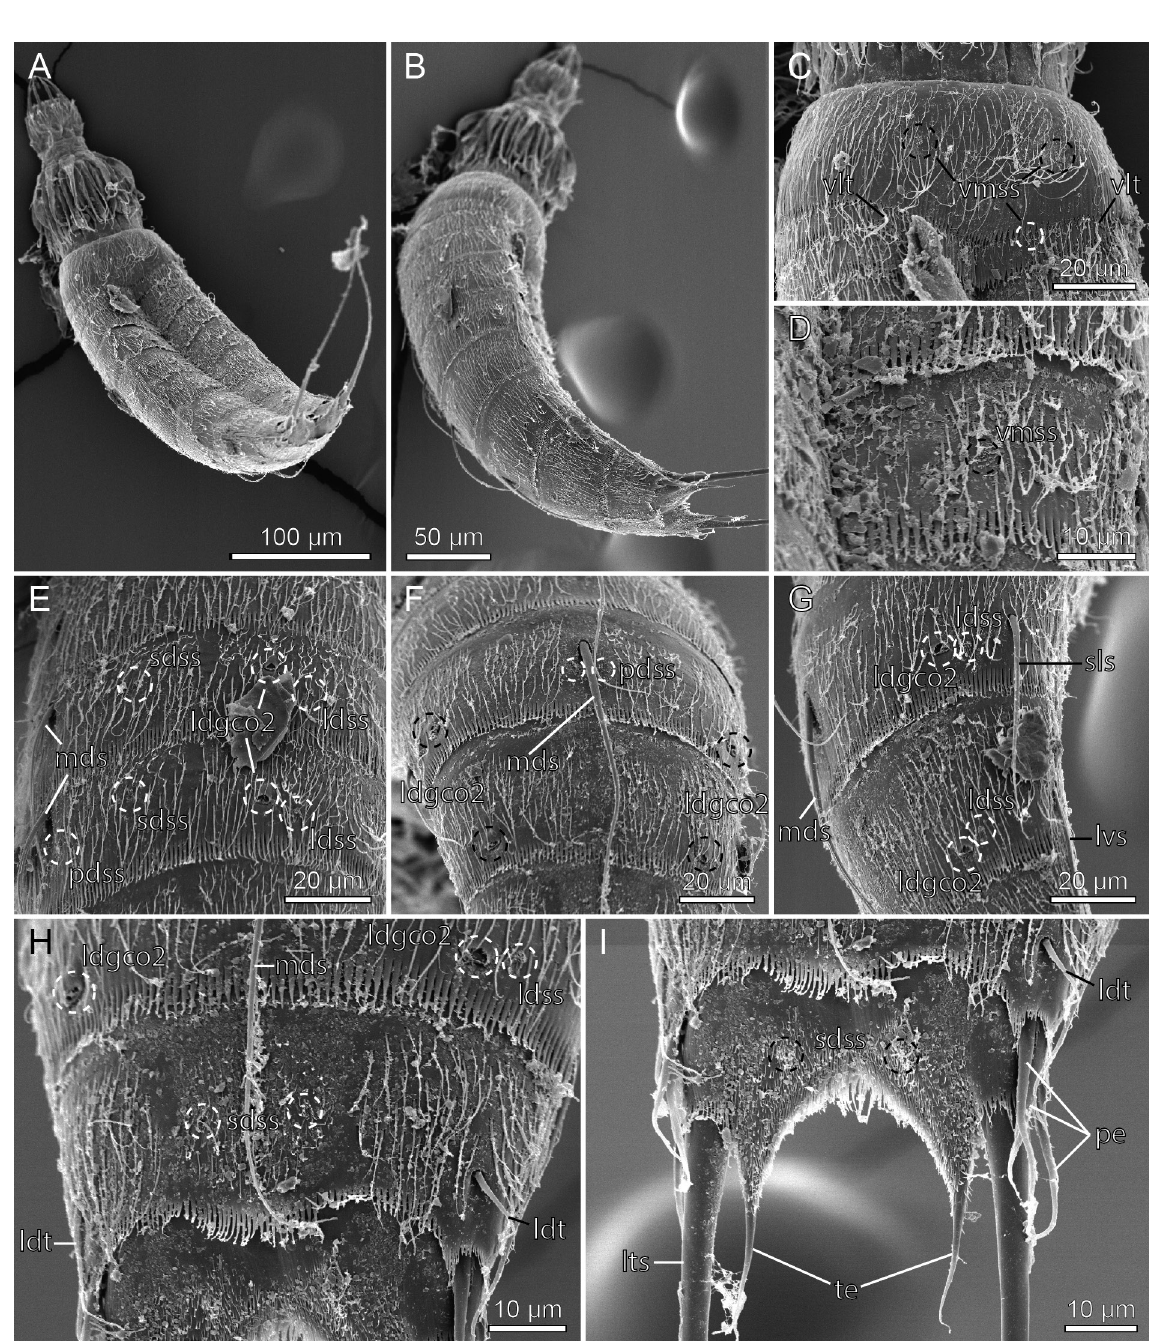
Fig. 27. Scanning electron micrographs showing overviews and details of Fissuroderes higginsi Neuhaus & Blasche, 2006, ♂. A . Ventrolateral overview. B . Lateral overview. C . Segments 1 to 2, ventral view. D . Detail showing left sternal plate of segment 6. E . Segments 4 to 6, laterodorsal view. F . Segments 8 to 9, dorsal view G . Segments 8 to 9, laterodorsal view. H . Segment 10, dorsal view. I . Segment 11, dorsal view. Abbreviations: ldgco2 = laterodorsal glandular cell outlet type 2; ldss = laterodorsal sensory spot; ldt = laterodorsal tube; lts = lateral terminal spine; lvs = lateroventral spine; mds = middorsal spine; pdss = paradorsal sensory spot; pe = penile spine; sdss = subdorsal sensory spot; sls = sublateral spine; te = tergal extensions; vlt = ventrolateral tube; vmss = ventromedial